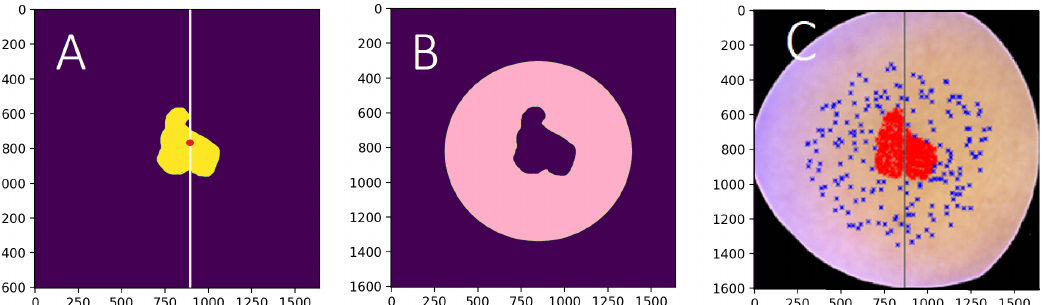
Figure 12. ( A ) The ground truth image, left side: training data, right side: test data. ( B ) The healthy skin mask is visualised with pink colour. ( C ) The visualisation of the selected training and testing data points. The selected lesion pixels are visualised in red, and blue represents the selected healthy skin pixels. The size of the HS image ( A , B ) was 1605 × 1640 px; the size of the divided training and testing portions ( C ) varies, depending on the lesion’s